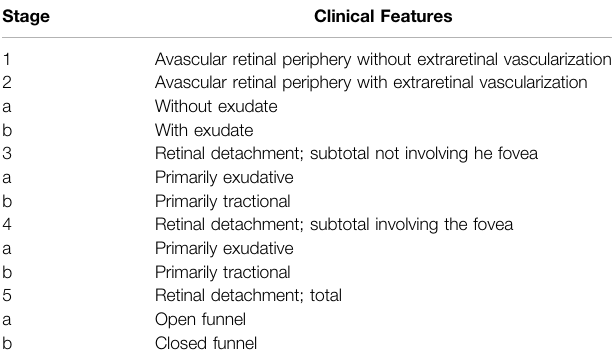
TABLE 1 | Classi fi cation of FEVR adapted from Pendergast and Trese, 1998. Stage